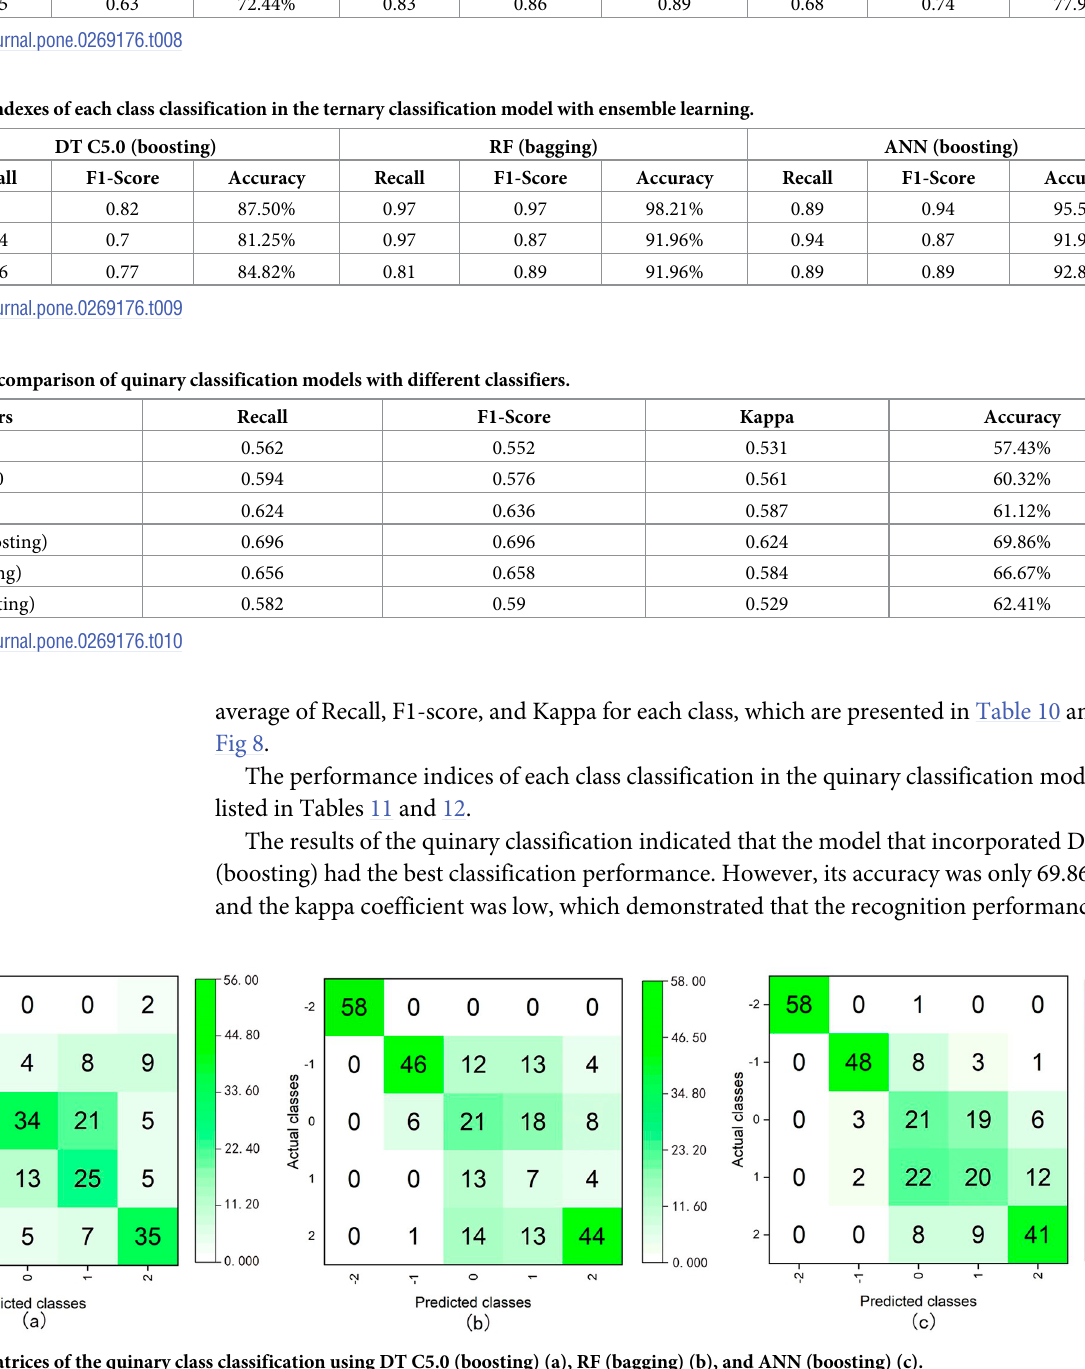
PLOS ONE | https://doi.org/10.1371/journal.pone.0269176 June 3,